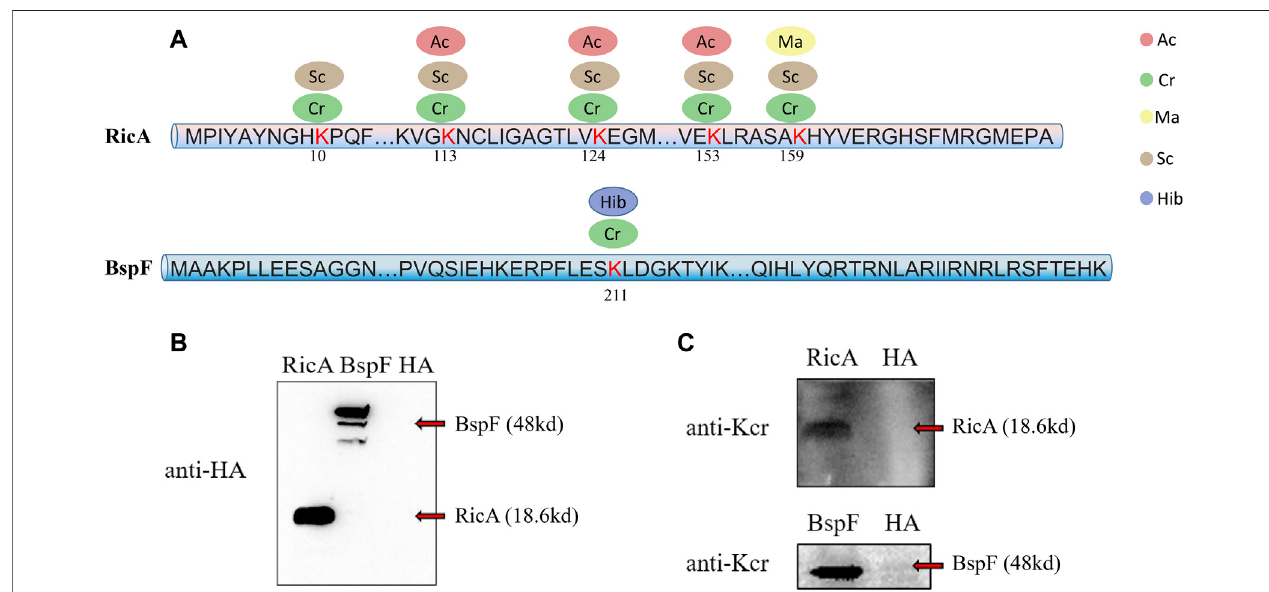
FIGURE2| Overviewof fi velysinemodi fi edsitesidenti fi edonRicAandBspFof B.abortus 2308andWesternblotveri fi cation.Fivelysinemodi fi edsitesofRicAand BspA are shown as (A) . Ellipses in blue, red, green, yellow and brown represent the numbers of sites modi fi ed by lysine 2-hydroxyisobutyrylation, acetylation, crotonylation, malonyllysine and succinylation. Numbers in the middle of the sequences indicate the amino acid position on histon. RicA and BspF were expressed normally veri fi ed by Western Blot with anti-HA antibody in (B) . Western blot analysis of 20 μ g of RicA and BspF with anti-crotonyllysine antibodies. RicA and BspF were detected in the expected place where is 19.25 and 47.08 kd respectively as shown in (C) .